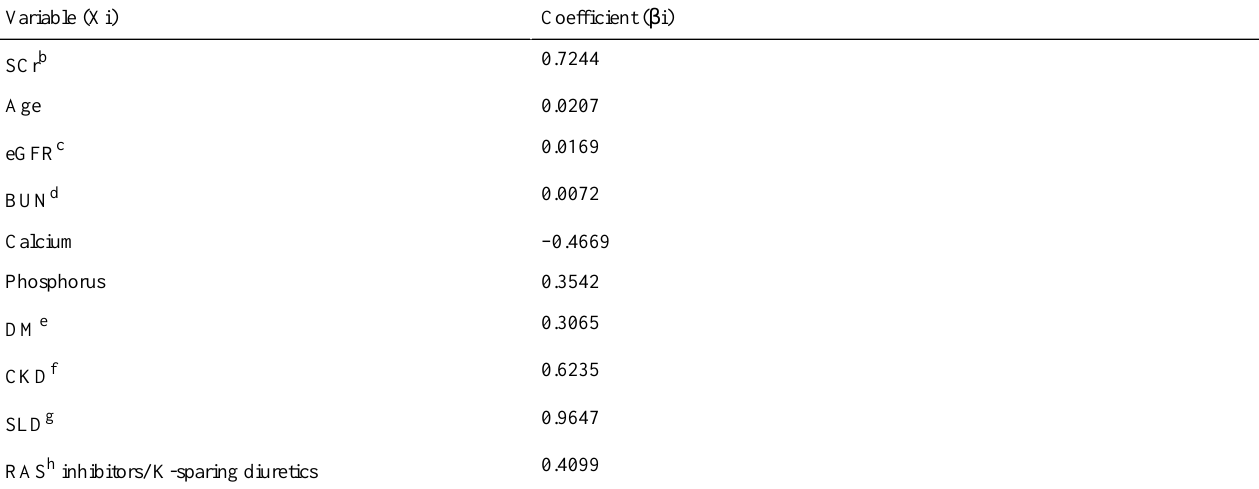
Table 3. Community-acquired acute kidney injury risk coefficients in the final model.